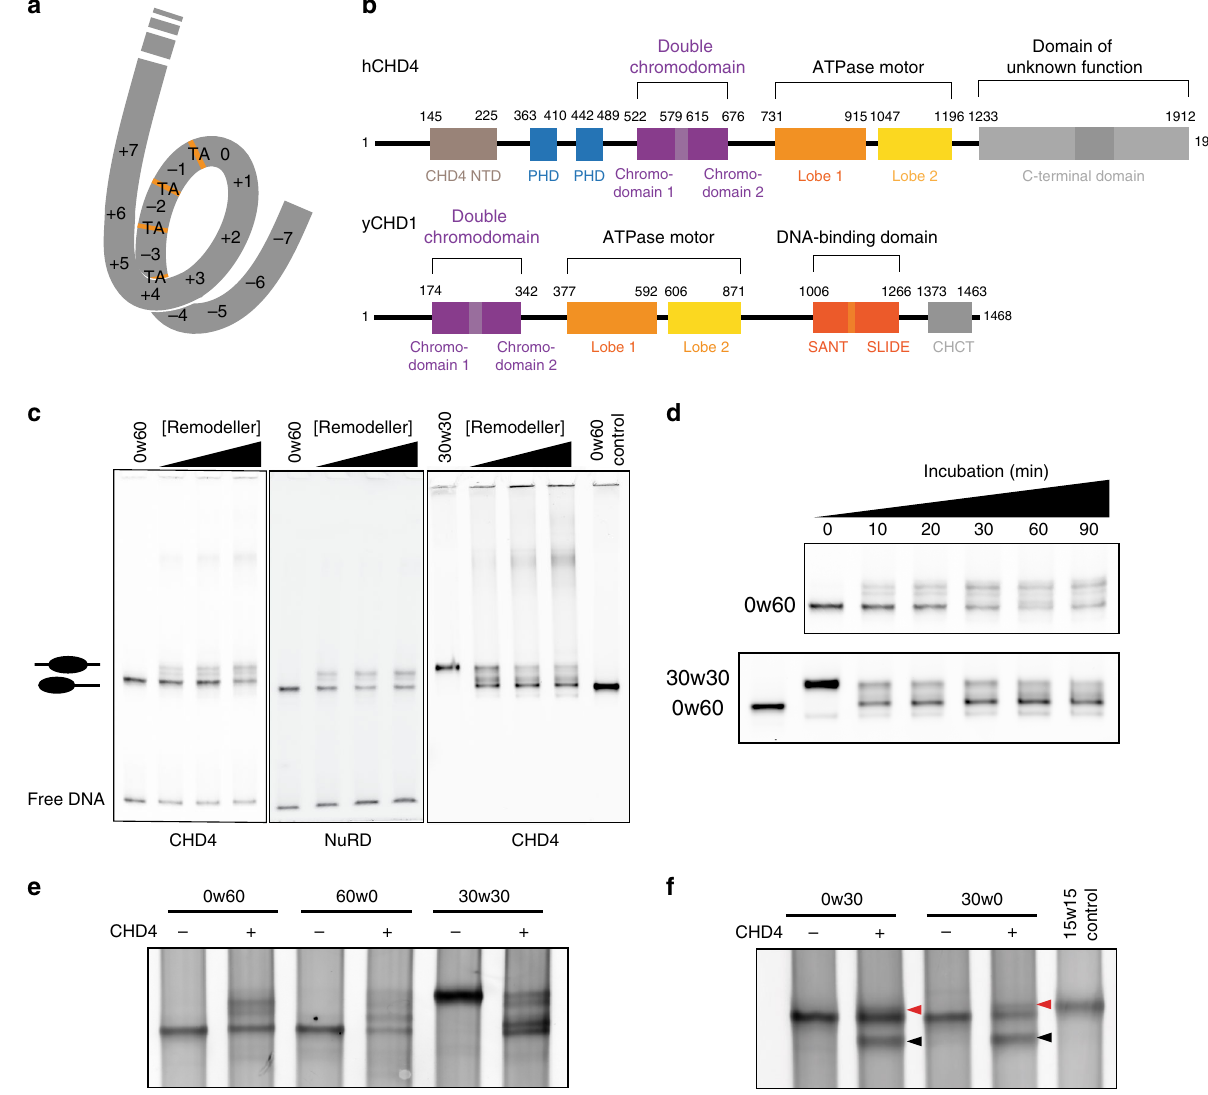
Fig. 1 CHD1/CHD4 domain topology and nucleosome repositioning assays. a Schematic showing the 15 superhelical location (SHL) sites, the most outward-facing positions of the minor groove, in the 601 nucleosome positioning sequence (labelled + 7 to – 7). The histone – DNA interface consists mainly of inward-facing sections of the DNA minor groove, which are de fi ned as superhelical locations (SHL) ± 0.5 – 6.5 31 . Orange bands indicate four phased TpA dinucleotides that are spaced 10 bp apart. b Domain architectures of yeast CHD1 and human CHD4 with residues at domain boundaries indicated (NTD: N- terminal domain, PHD: plant homeodomain, CHCT: CHD1 C-terminal domain). c Gel-based nucleosome repositioning assays carried out with the indicated nucleosomes and remodellers. Fluorescently labelled nucleosomes were treated with the indicated remodeller for 60 min, the reaction was stopped by adding dsDNA (33 µ g/mL) and then the samples were run on 5% native polyacrylamide gels. Symmetrically positioned nucleosomes are retarded relative to asymmetrically positioned species, as indicated. d Gel-based nucleosome repositioning assays carried out as described in ( c ), except that an incubation time-course was carried out at a single CHD4 concentration (5 nM). Assays using 0w60 (upper panel) or 30w30 (lower panel) substrates are shown; a 0w60 control lane was included in the lower panel. Source data are provided as a Source Data fi le. e , f Nucleosome sliding assays carried out as described in ( c ), using the indicated nucleosome substrates and 5 nM CHD4. Remodelled products (0w30 and 30w0) are indicated by red arrows, and the possible hexosome band is indicated by black arrows. Source data are provided as a Source Data fi